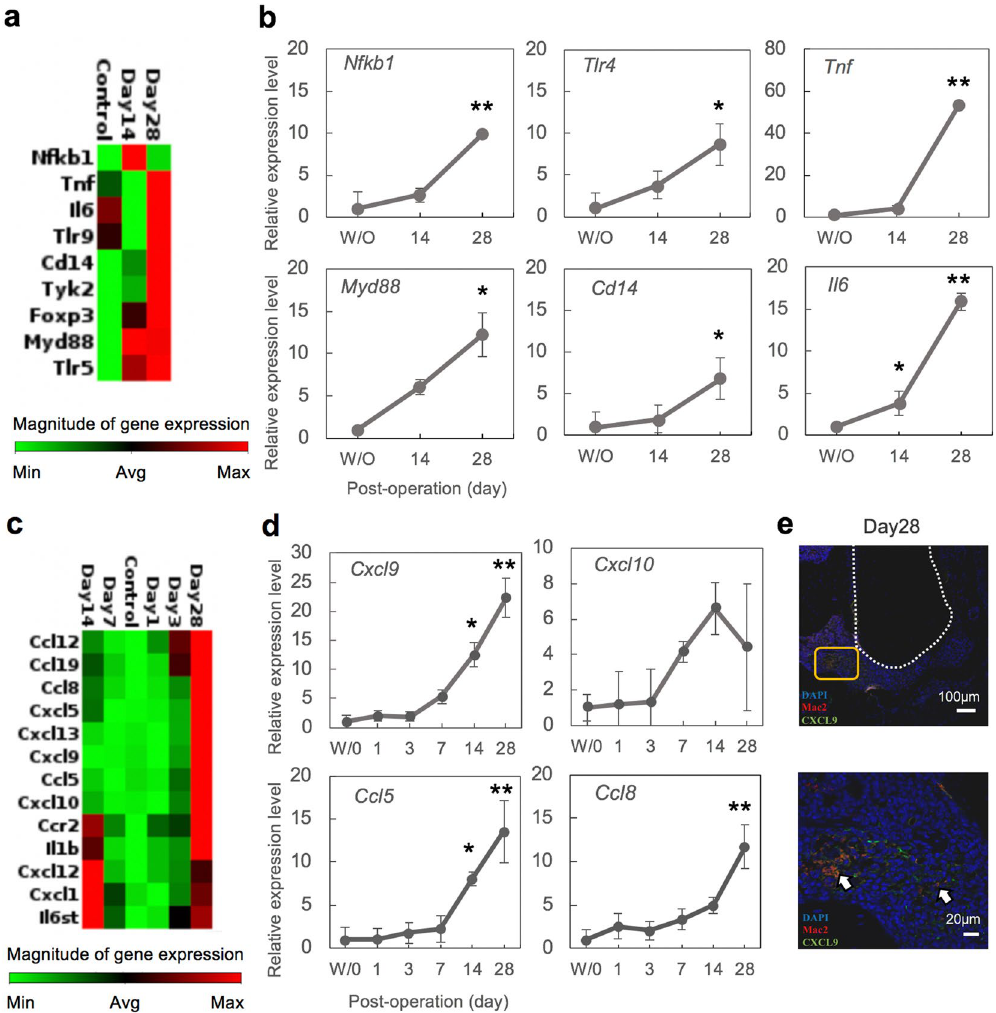
Figure 2. Inflammatory markers especially chemokines are highly expressed in periapical lesions. ( a ) Clustergram analysis of the gene expression patterns for inflammation-associated factors during the development of AP (n = 1 per group). ( b ) Validation of the inflammation-associated factors by quantitative PCR analysis. Normalization was based on the GAPDH expression in the without (W/O) exposure group. Statistical analysis was performed using the Dunnett test in comparison with the W/O group; *p < 0.05, **p < 0.01 (mean ± SD, n = 4 per group). ( c ) Clustergram analysis of inflammatory mediator and receptor genes identified during the development of AP (n = 1 per group). ( d ) Validation of the inflammatory markers by quantitative PCR analysis. Statistical analysis was performed using the Dunnett test in comparison with the W/O group; *p < 0.05, **p < 0.01 (mean ± SD, n = 4 per group). ( e ) Representative images of immunostained CXCL9- and Mac2-positive macrophages (arrows) at 28 days after pulp exposure. The lower panel shows a higher magnification image of the framed region in the upper